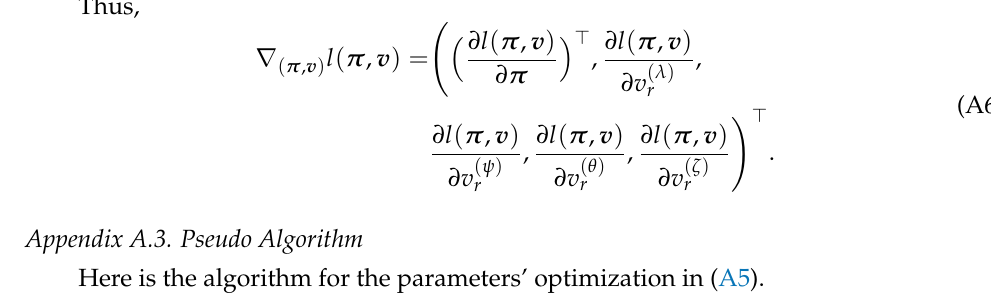
Algorithm A1 Adam based method for parameter optimization. Good default settings for the analyzed COVID-19 dataset are learning rate η = 0.05, exponential decay rates b 1 = 0.1 and b 2 = 0.1, and γ = 1 10 − 8 . Algorithm tolerance tol = 1 ×